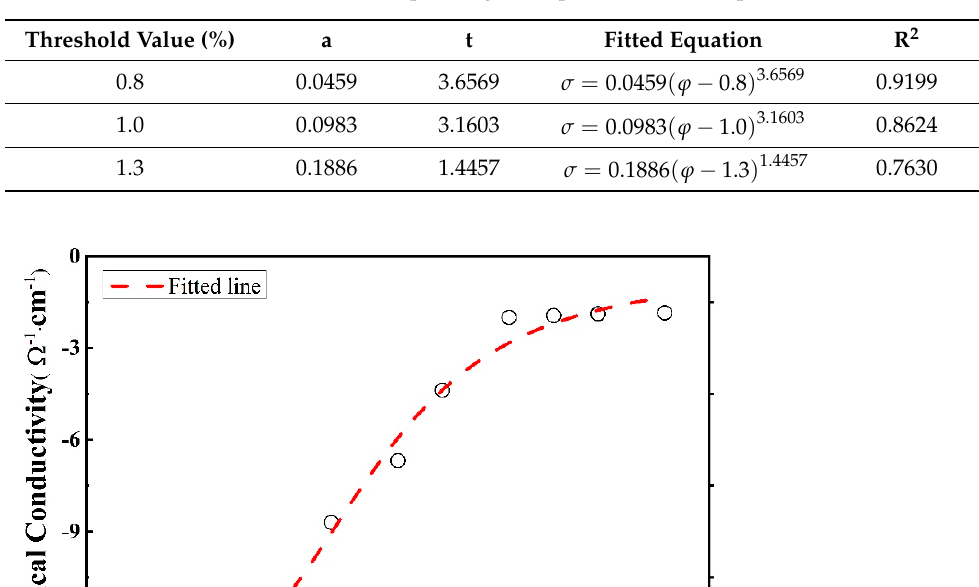
Table 3. Percolation threshold and corresponding fitted parameters and equations.